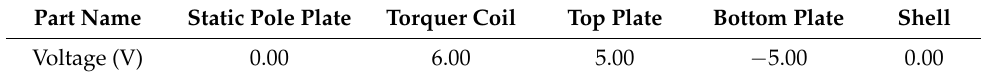
Table 5. Excitation voltage value of each